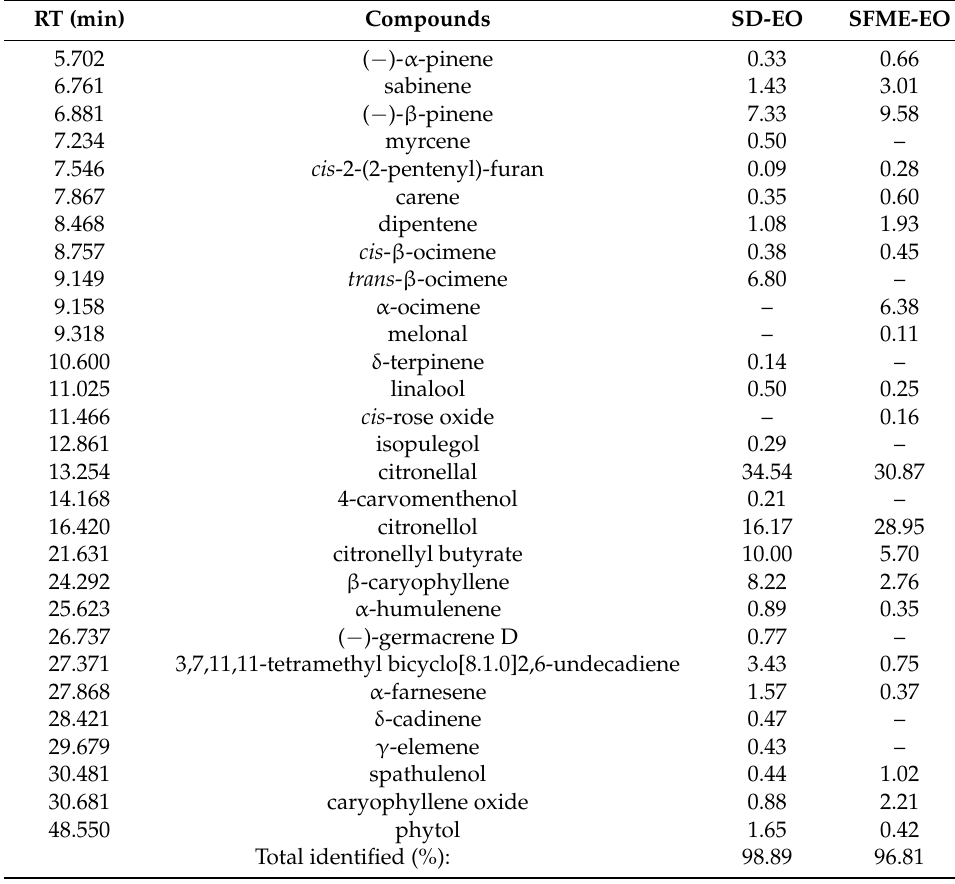
Table 1. Chemical composition percentage a of ‘Mato Peiyu’ leaf essential oil determined through gas chromatography–mass spectrometry analysis.